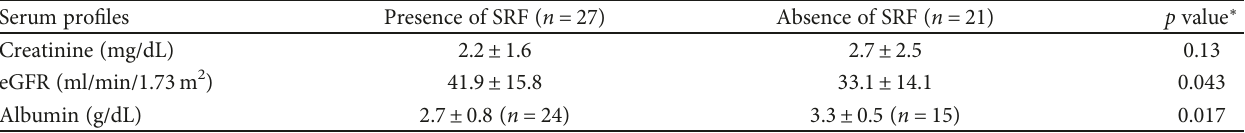
Table 4: Correlation of baseline status of subretinal fl uid to renal parameters in chronic kidney disease. Serum pro fi les